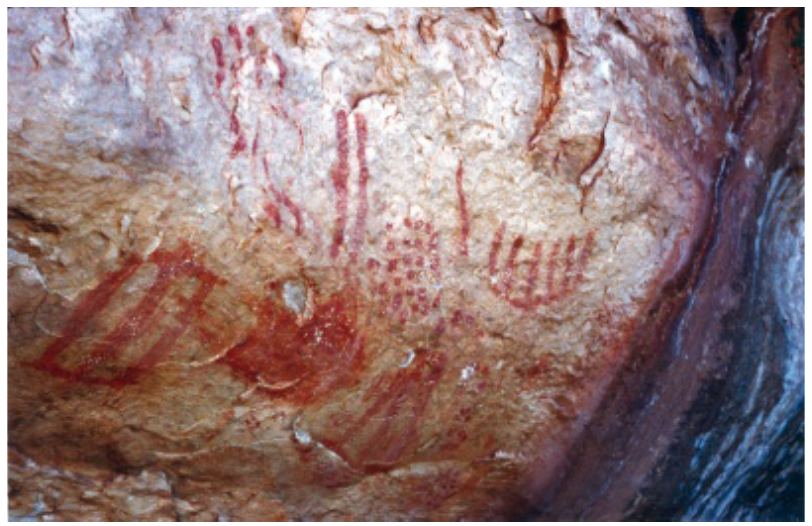
Figure 7. Paintings from Amzri (photo